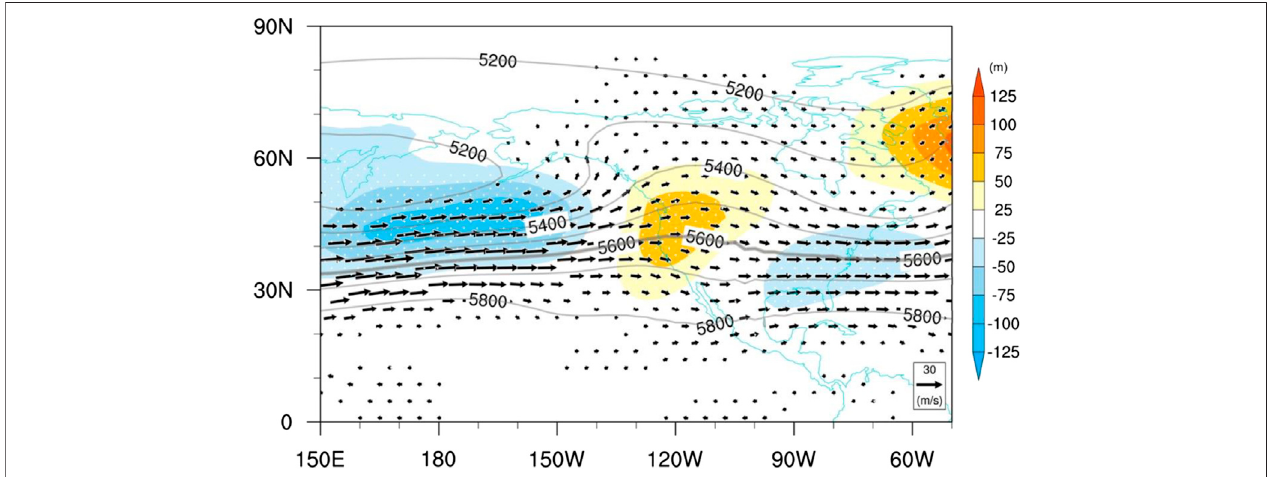
FIGURE 4 | Monthly mean wind fi elds (vector), geopotential height (contours) and the anomaly (color) from spring climatology at 500 hPa, for extreme EN (with 100 m contours). The thicker line indicates 5600 m. Geopotential height anomalies that are signi fi cant at the 95% con fi dence level (Student ’ s t -test) are stippled. Figure for the moderate EN case with no obvious response were omitted.